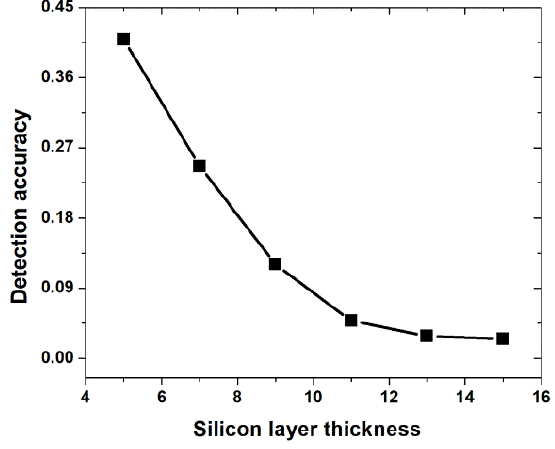
Figure 10. DA with silicon thickness for bio sensing probe graphene layer (L = 4) with 50 nm of Au for refractive index 1.33 RIU. The square symbols are simulated data points, which are fitted with black line.